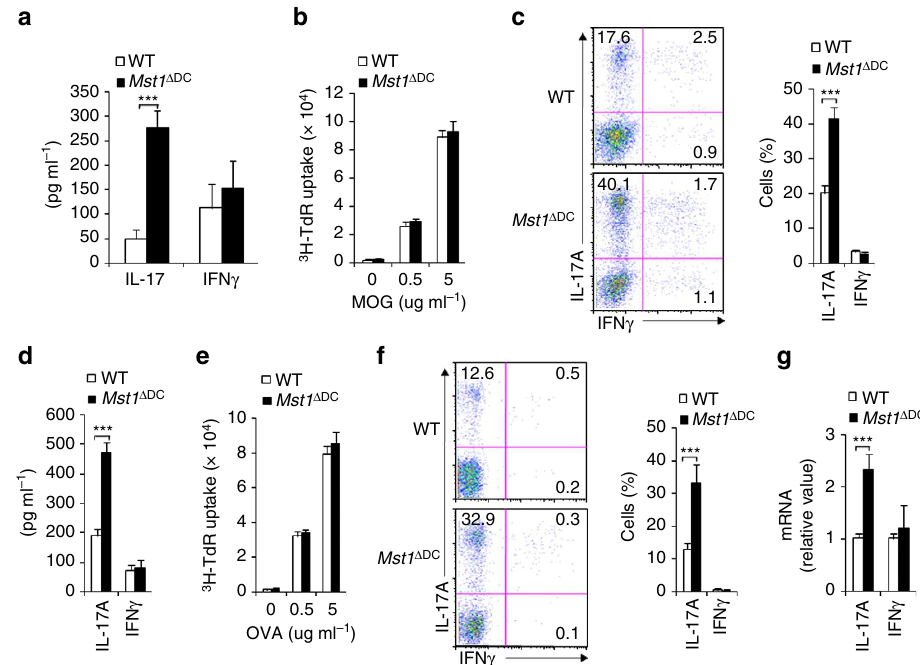
Figure 4 | DC MST1 signalling directs Th17 differentiation in vivo . ( a ) WTor Mst1 D DC mice were immunized with OVA þ CFA for 7–8 days. The Tcells were isolated from the dLN and restimulated ex vivo for 3 days with OVA (5 m gml (cid:2) 1 ) in the presence of irradiated splenocytes, and the secretion of indicated cytokines were analysed by ELISA. ( b – d ) Naive MOG-transgenic 2D2 Tcells (Thy1.1 þ ) were transferred into WTor Mst1 D DC mice and immunized with MOG þ CFA for 7–8 days. ( b ) Proliferation of dLN cells was determined with 3 H-TdR incorporation. ( c ) Expression levels of IL-17A and IFN g in donor cells in dLN. Right, proportion of IL-17A and IFN g in donor cells. ( d ) Secretion of IL-17 and IFN g in donor cells stimulated with MOG for 72h. ( e , f ) Naive OT-II T cells (Thy1.1 þ ) were transferred into WT or Mst1 D DC mice and immunized with OVA þ CFA for 7–8 days. ( e ) Proliferation of dLN cells was determined with 3 H-TdR incorporation. ( f ) Expressions of IL-17A and IFN g in donor cells in the dLN. Right, proportion of IL-17A and IFN g in donor cells. ( g ) mRNA expression of IL-17 and IFN g in donor cells stimulated with OVA for 72h. Levels in WT control groups were set to 1. Data are representative of three to four independent experiments (mean ± s.d.; n ¼ 3–6). *** P o 0.001, compared with the indicated groups. P -values were determined using Student’s t